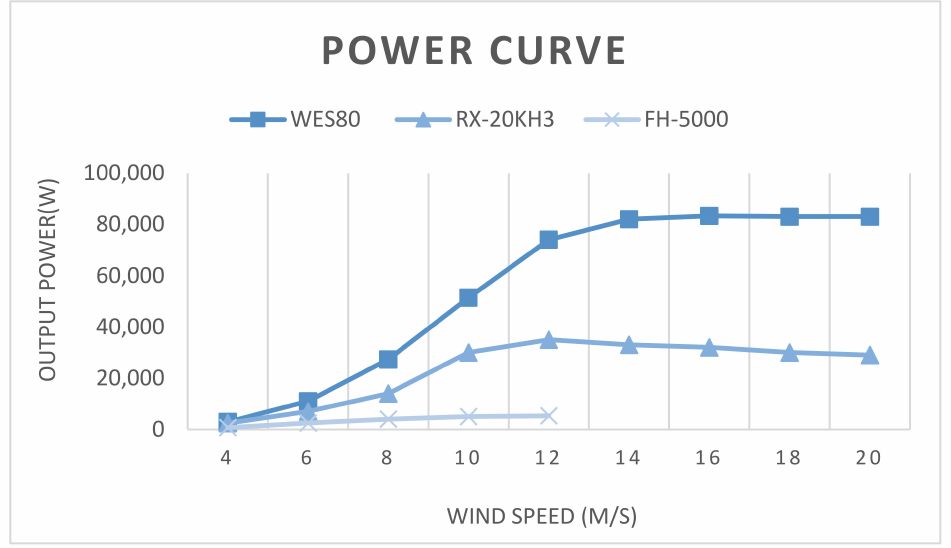
Figure 7. Power curve of the selected wind